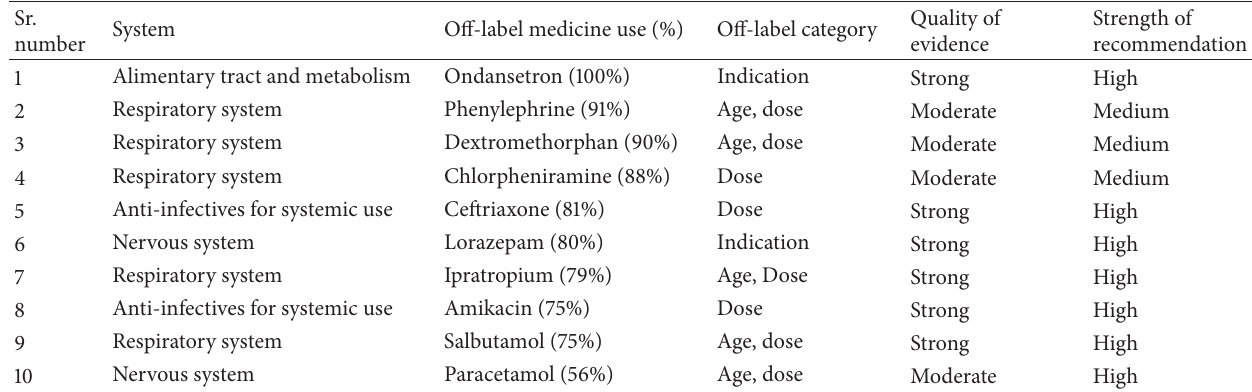
Table 4: Most frequently prescribed off-label medicines.